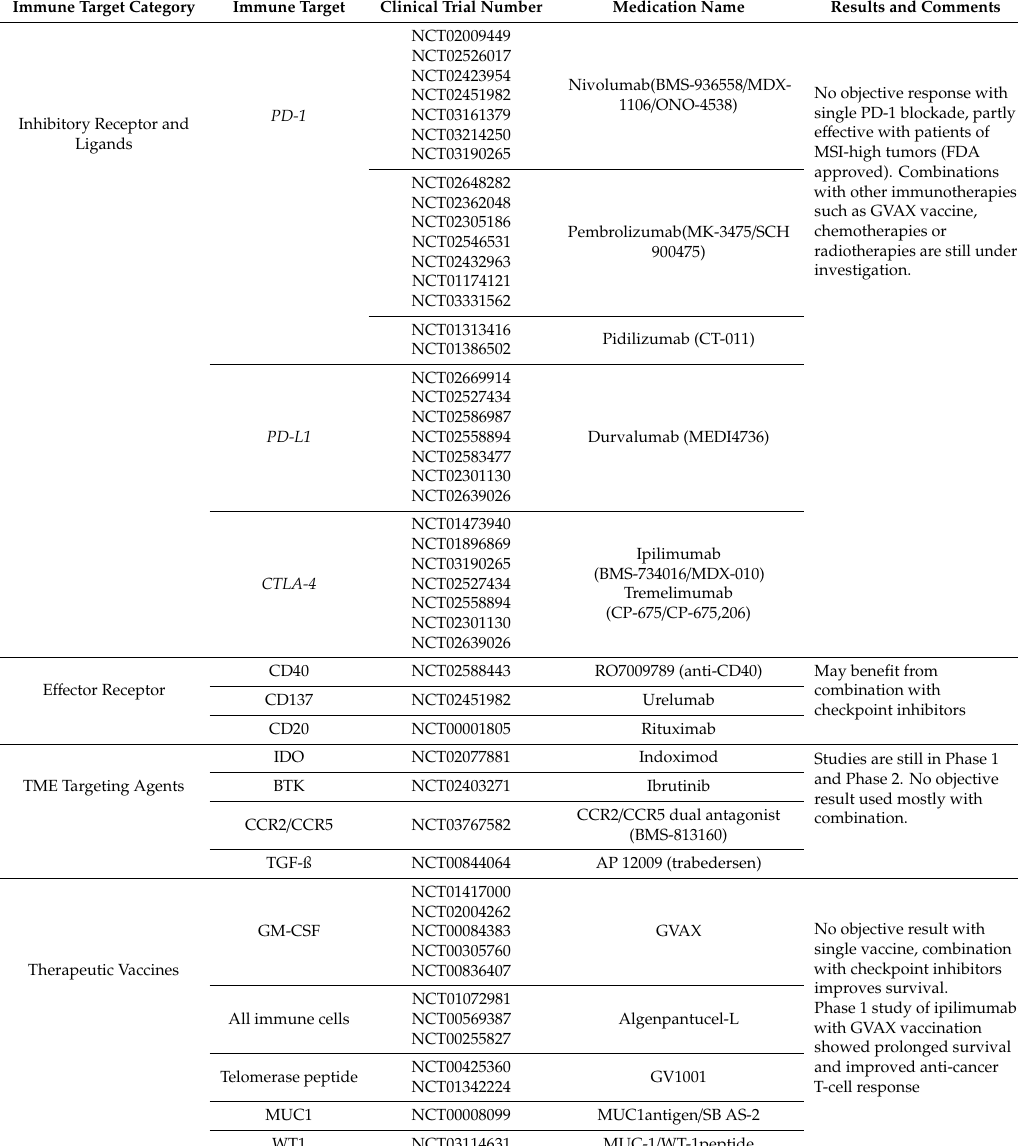
Table 1. Clinical trials of potential immunotherapeutic targeting main or mediatory immunosuppressive molecules for PDAC